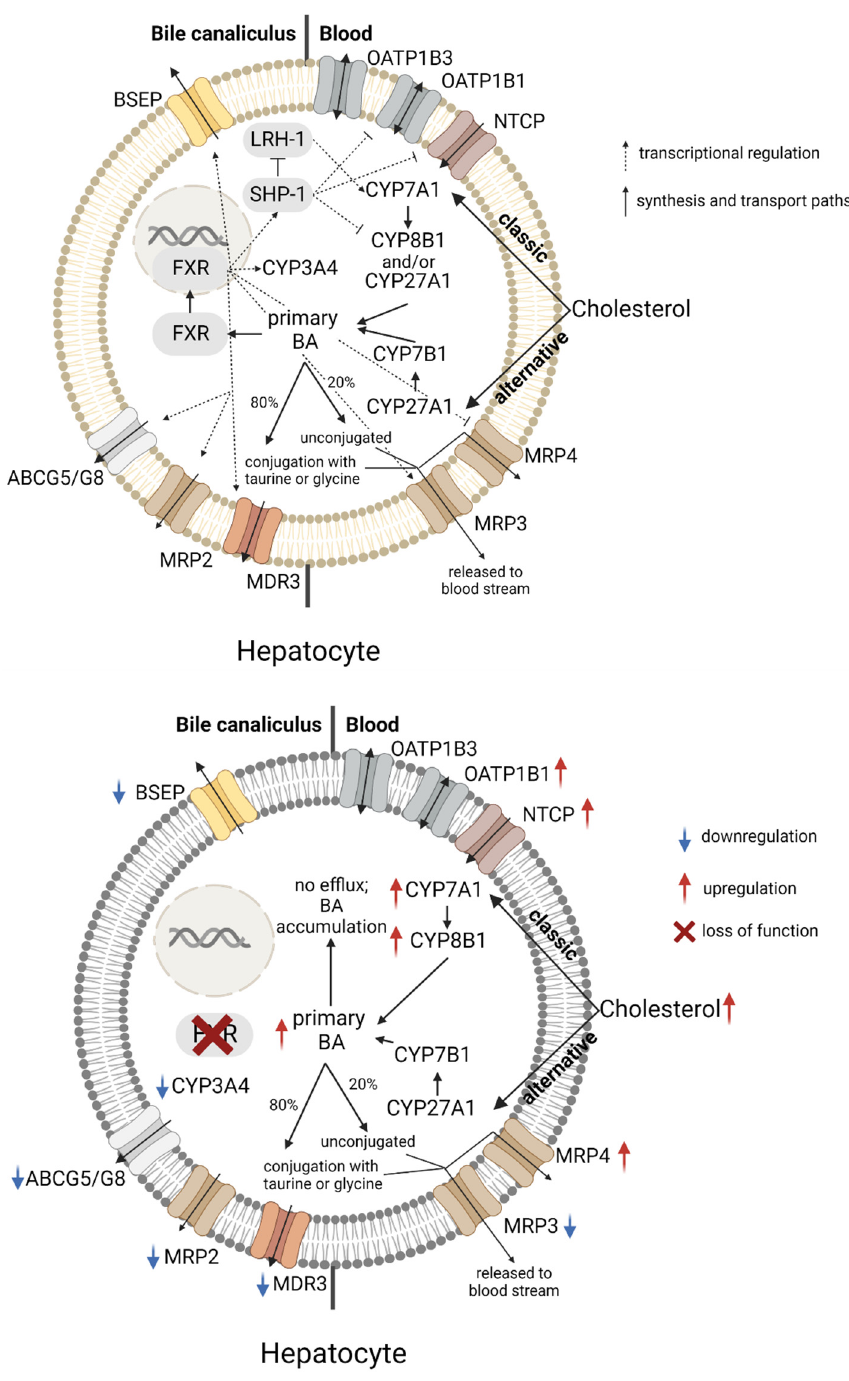
Figure 1. Schematic representation of the regulatory role of FXR in bile acid homeostasis. Top panel: Under physiological conditions, hepatocytes convert cholesterol to bile acids following the classic or alternative pathway. Bile acids can bind to and activate FXR, which translocates to the nucleus, where it induces the transcription of genes encoding proteins involved in BA synthesis, transport and degradation, in order to maintain sub-toxic BA intracellular levels. Bottom panel : Reduced expression and/or function of FXR leads to an increased BA synthesis, and reduced BA efflux and degradation. ABCG = ATP-binding cassette subfamily G, BA = Bile acid, BSEP = Bile salt export pump, CYP = Cytochrome P450, FXR = Farnesoid X receptor, LRH-1 = Liver receptor homolog 1, MDR = Multidrug resistance protein, MRP = Multidrug resistance associated protein, NTCP = Sodium-taurocholate cotransporting polypeptide, OATP = Organic anion transporter protein, SHP-1 = Small heterodimer protein-1; Figure has been created with